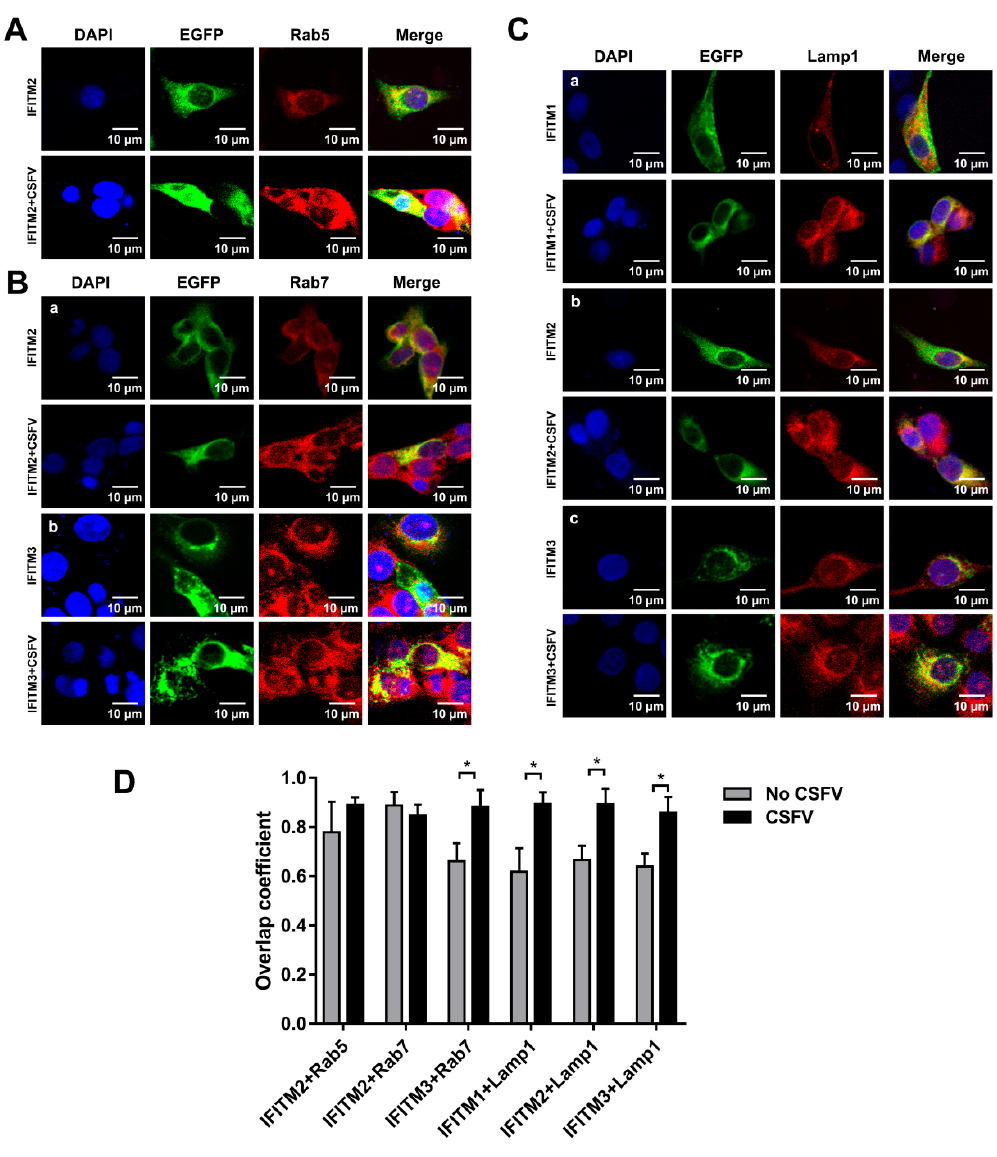
Figure 7. Colocalization of IFITMs with Rab5, Rab7, and Lamp1. Confocal images of IFITM colocalization with Rab5 ( A ), Rab7 ( B ), and Lamp1 ( C ) in mock-infected and CSFV-infected PAMs. The expression of Rab5, Rab7, and Lamp1 was visualized by immunofluorescence staining with an anti-Rab5, anti-Rab7, or anti-Lamp1 antibody, followed by the Alexa Fluor 594 AffiniPure goat anti-rabbit IgG (H + L) antibody. ( A ) PAMs were transfected with IFITM-expressed plasmid for 24 h and then mock-infected or infected with CSFV at an MOI of 1. PAMs were fixed at 24 hpi and stained with anti-Rab5 antibody (red). Nuclei (blue) were stained with DAPI. ( B ) PAMs were transfected with IFITM-expressed plasmid for 24 h, followed by CSFV (MOI = 1) infection for another 24 h. PAMs were stained with anti-Rab7 antibody (red) and DAPI (blue). ( C ) PAMs transfected with IFITM-expressed plasmid for 24 h were infected with CSFV (MOI = 1) for another 24 h. PAMs were stained with anti-Lamp1 antibody (red). Nuclei (blue) were stained with DAPI. Scale bars, 10 µ m. ( D ) Overlap quantification of IFITMs with Rab5, Rab7, and Lamp1 was performed using Image J software and measured for individual cells. More than 10 cells were analyzed for each set with statistical tests carried out using Prism. * p < 0.05.